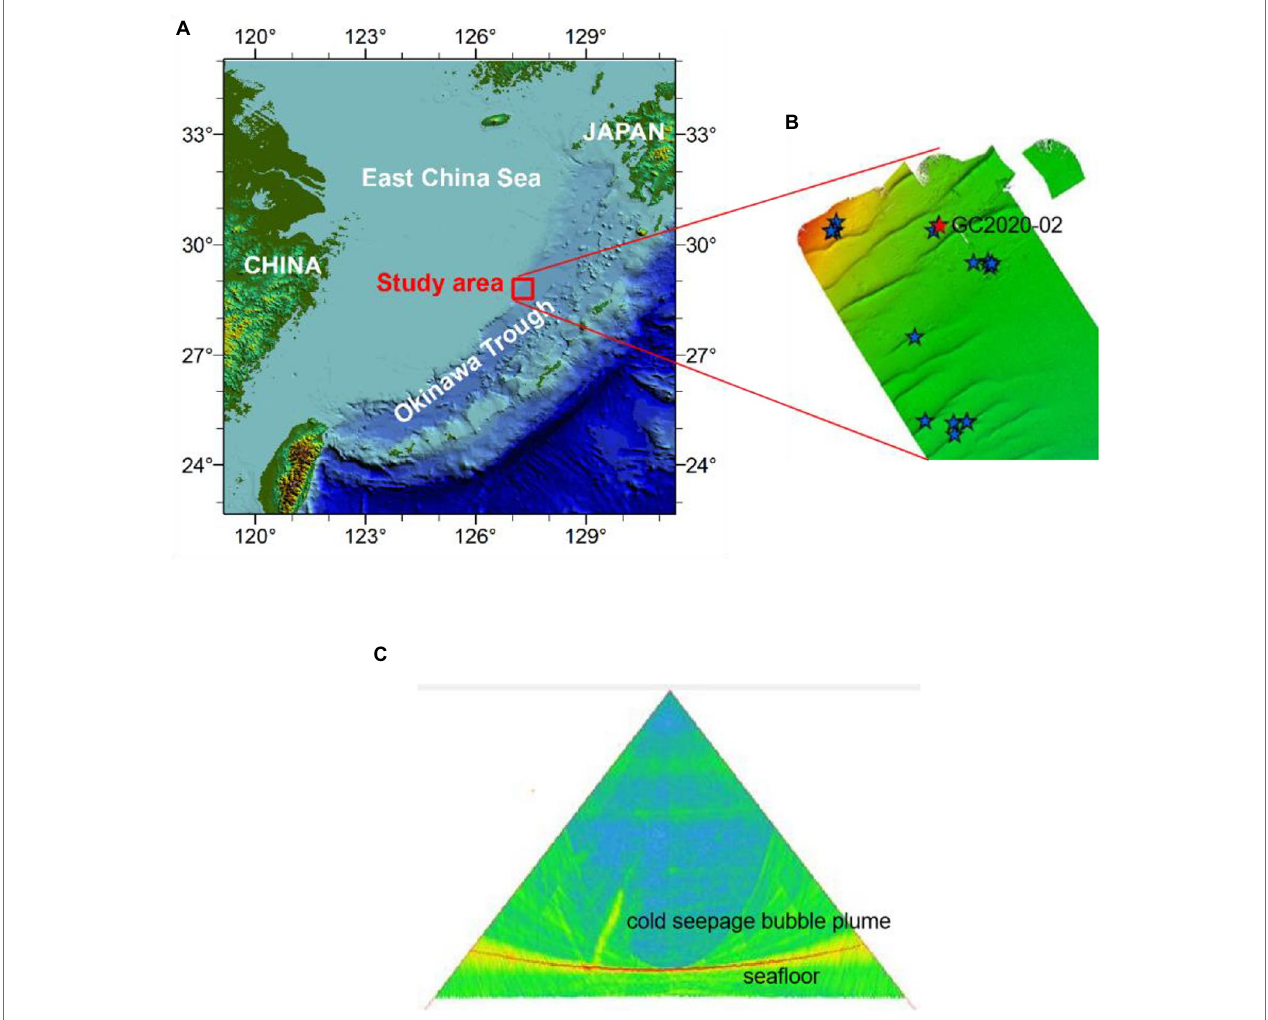
FIGURE 1 | Topographical profile of the Okinawa Trough (OT; A ), multibeam topographic map (B) , and multibeam backscatter image (C) of the study area [in the multibeam topographic map (B) , the five-pointed stars represent the distribution of acoustic plumes in water, and the red five-pointed stars represent sampling site